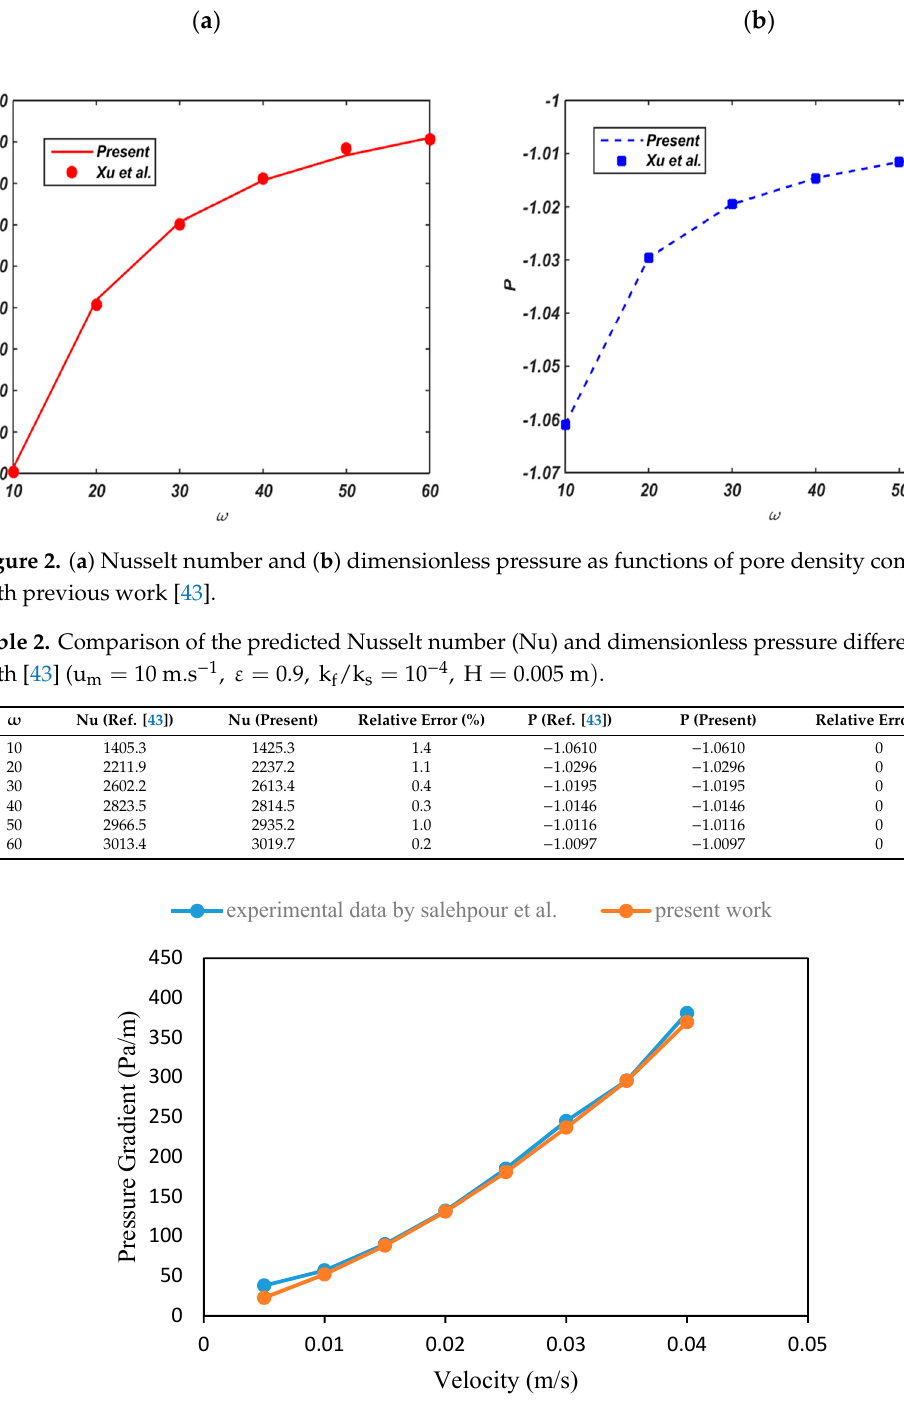
Figure 3. Pressure gradient as a function of velocity compared with previous experimental works [44].